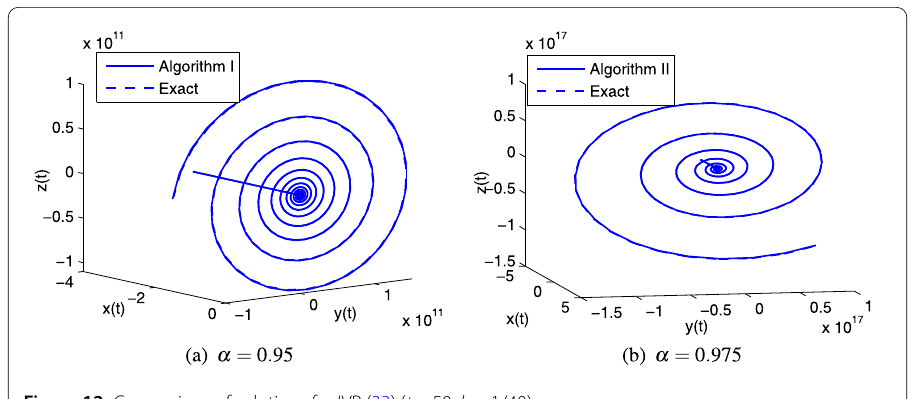
Figure 12 Comparison of solutions for IVP (33) ( t = 50, h =